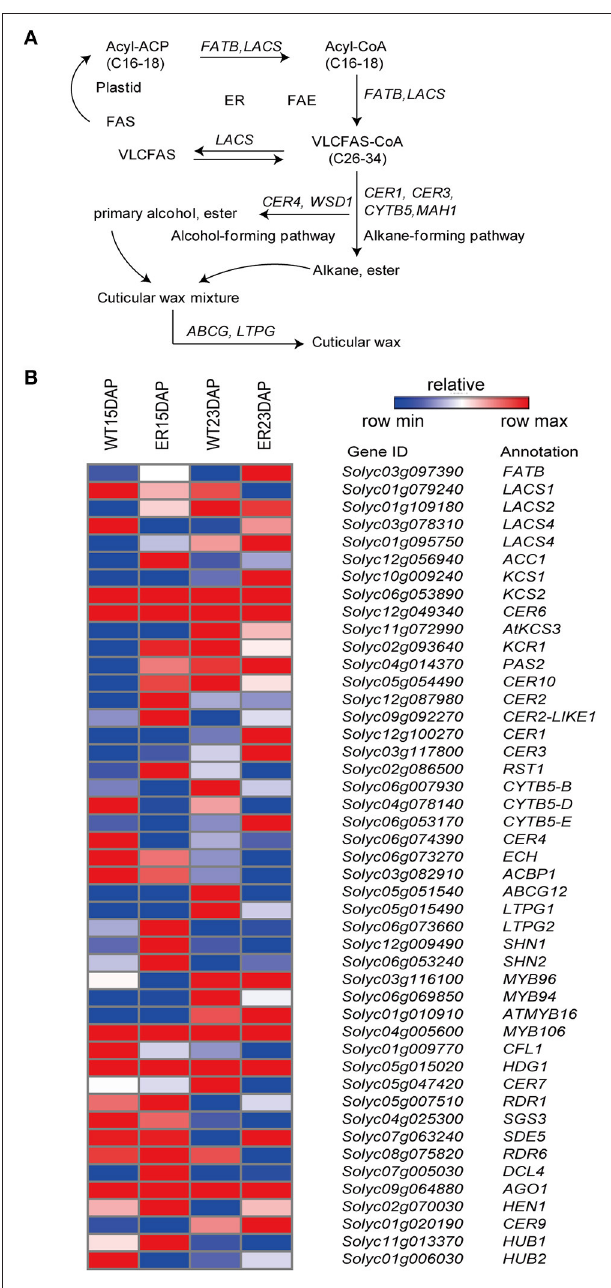
FIGURE 5 | Analysis of differentially expressed genes (DEGs) involved in the wax biosynthesis pathway between epidermal reticulation (ER) and WT fruit exocarp. (A) Schematic diagram of wax biosynthesis (Saetbuyl and Michung, 2015). (B) The expression profile of genes encoding key enzymes in the pathway. The FPKM (fragments per kilobase of transcript per million mapped reads) value is the average of three biological replicates. Abbreviations are listed in Table